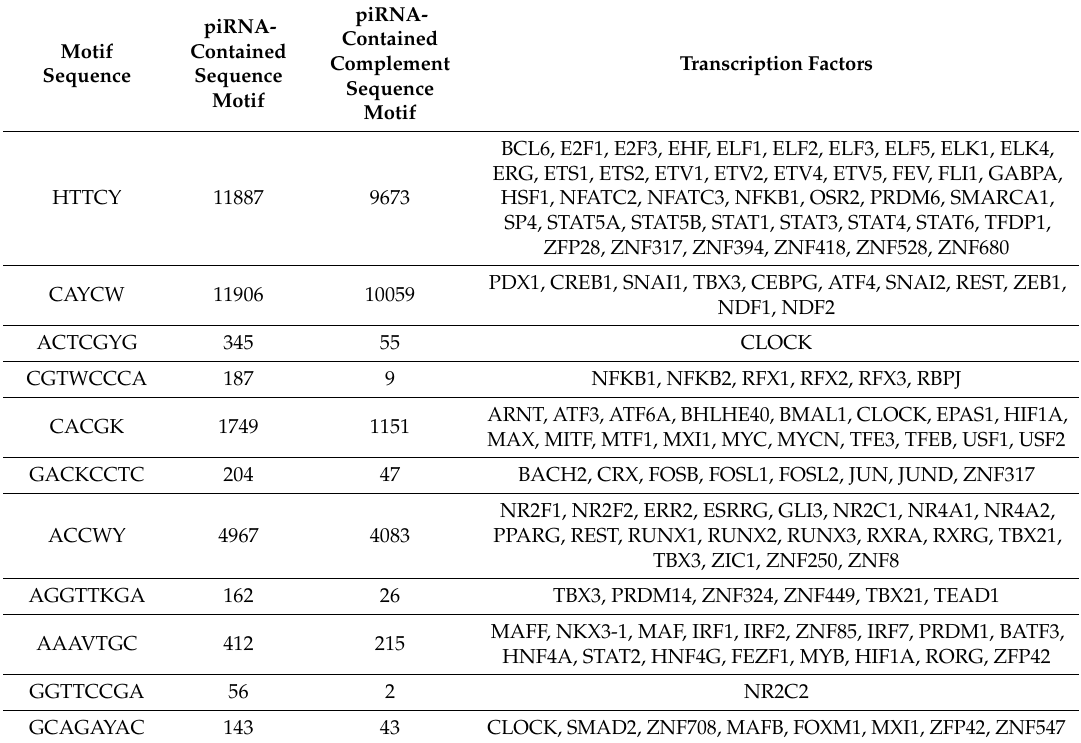
Table 2. PIWI-interacting RNA (piRNA) conserved